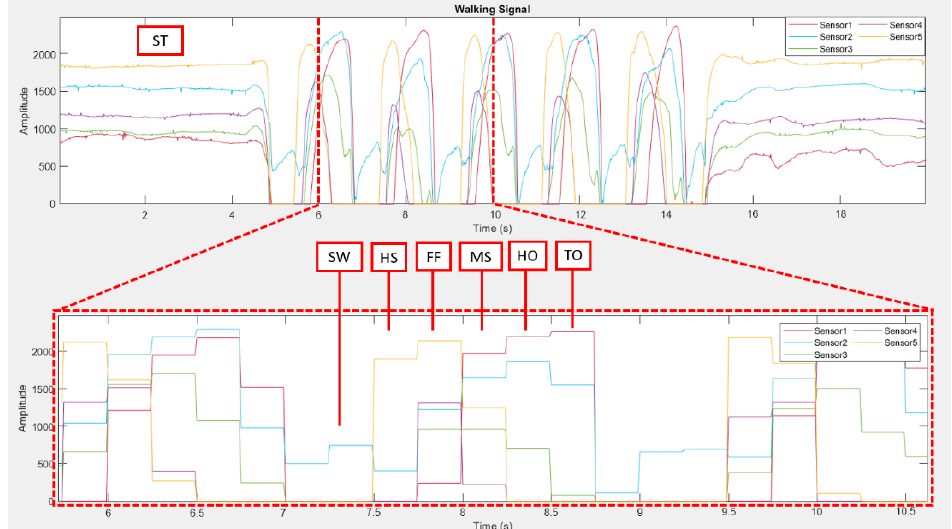
Figure 4. The example of dividing a sensor signal into 7 segments by MATLAB. (ST: stand, SW: swing, HS: heel strike, FF: foot flat, MS: midstance, HO: heel off, TO: toe-off).